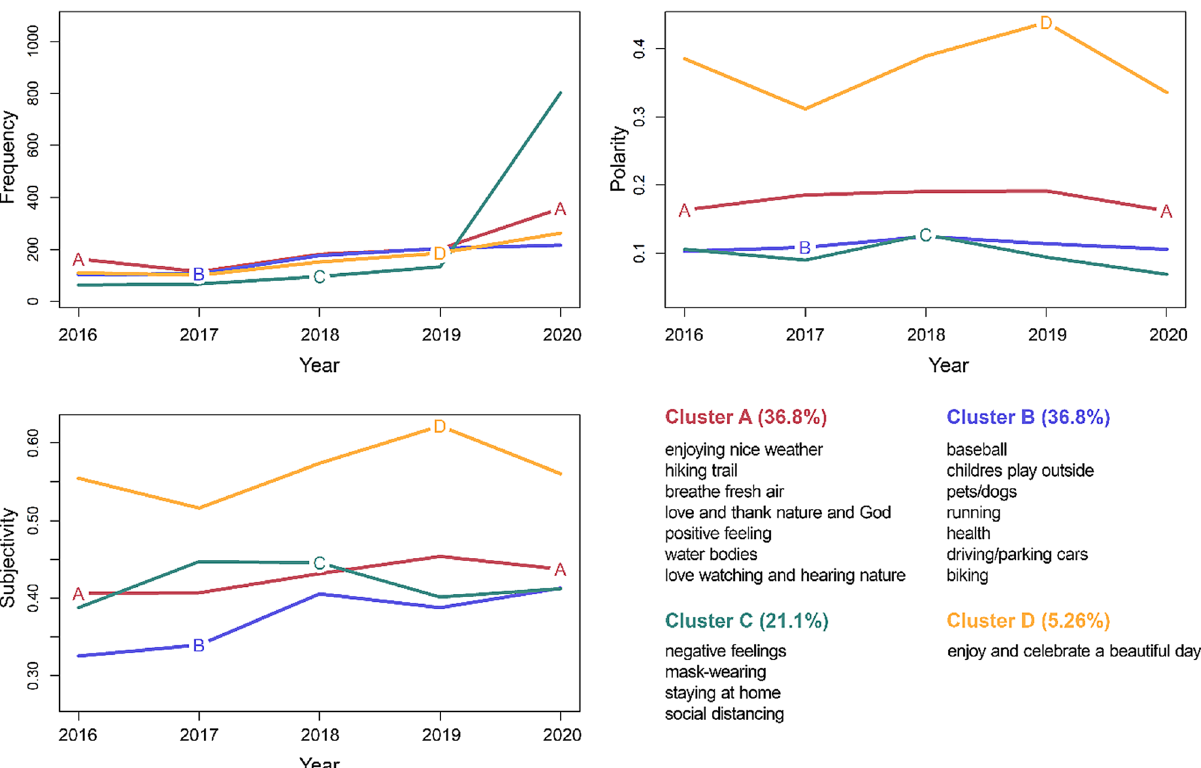
Figure 4. Four clusters representing unique trajectories of frequency, polarity, and subjectivity.